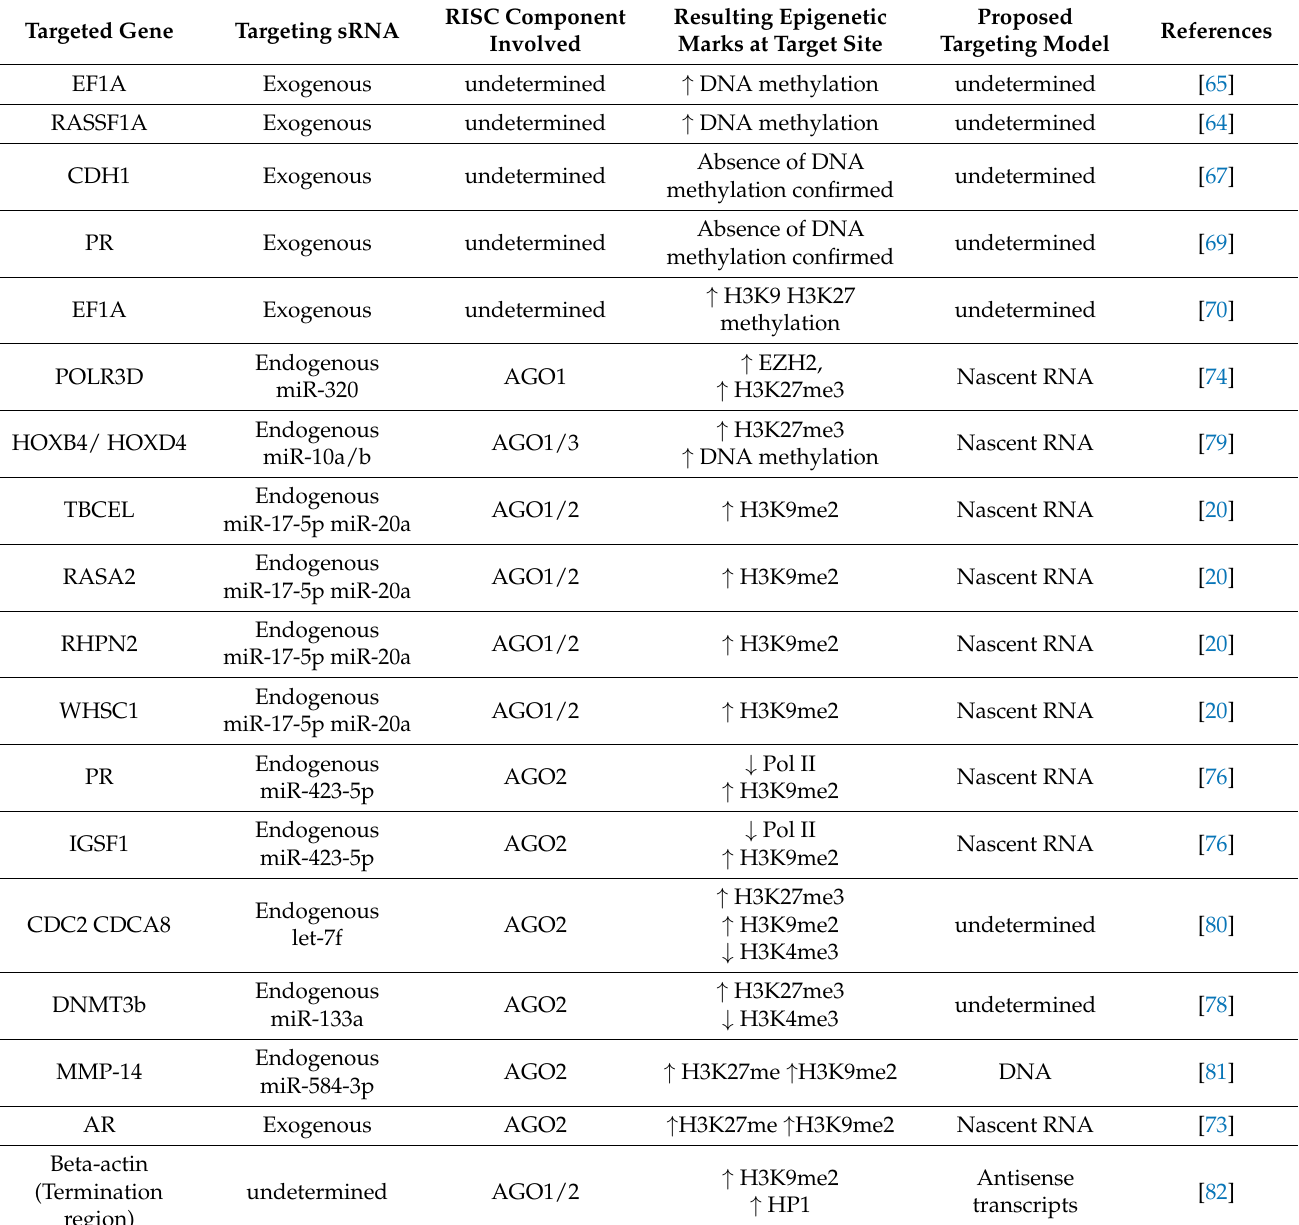
Table 1. Summary of studies showing genes regulated by TGS mechanisms in mammals. The region targeted by the small RNA falls within the promoter of the gene, unless stated